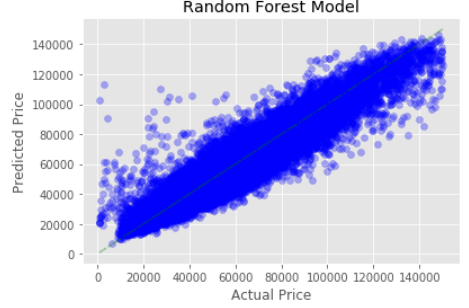
Figure 7. Histogram of sensitivity score.